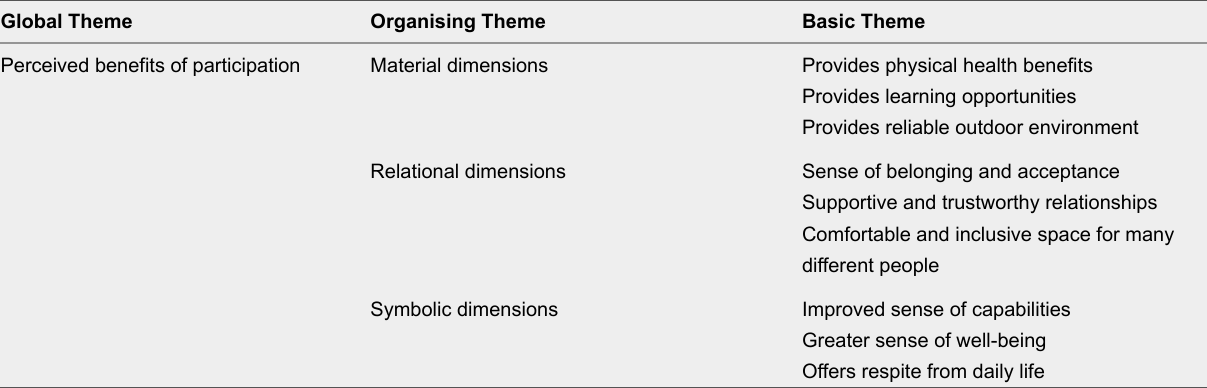
Coding Framework for Perceived Benefits of